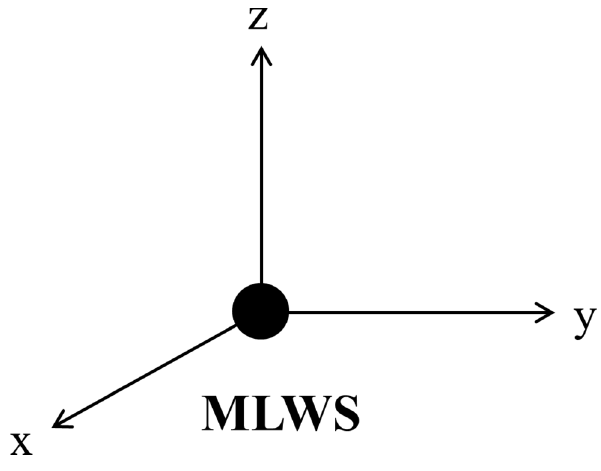
Figure 4. MLWS as a new starting point. x, y and z axis each represent reoriented transverse, anteroposterior and vertical axis.